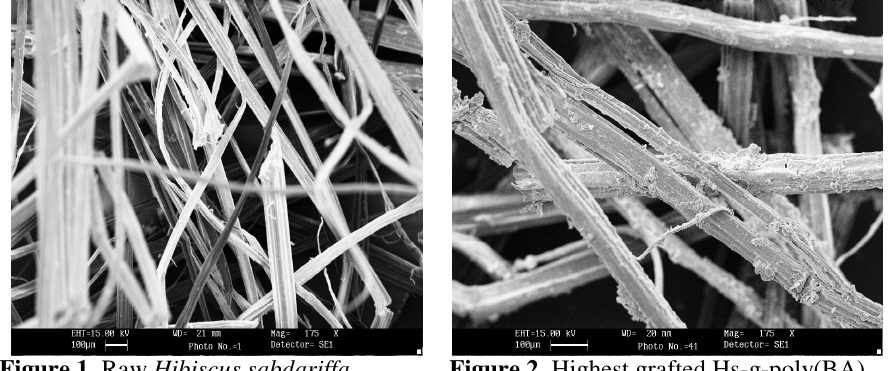
Figure 1. Raw Hibiscus sabdariffa Figure 2. Highest grafted